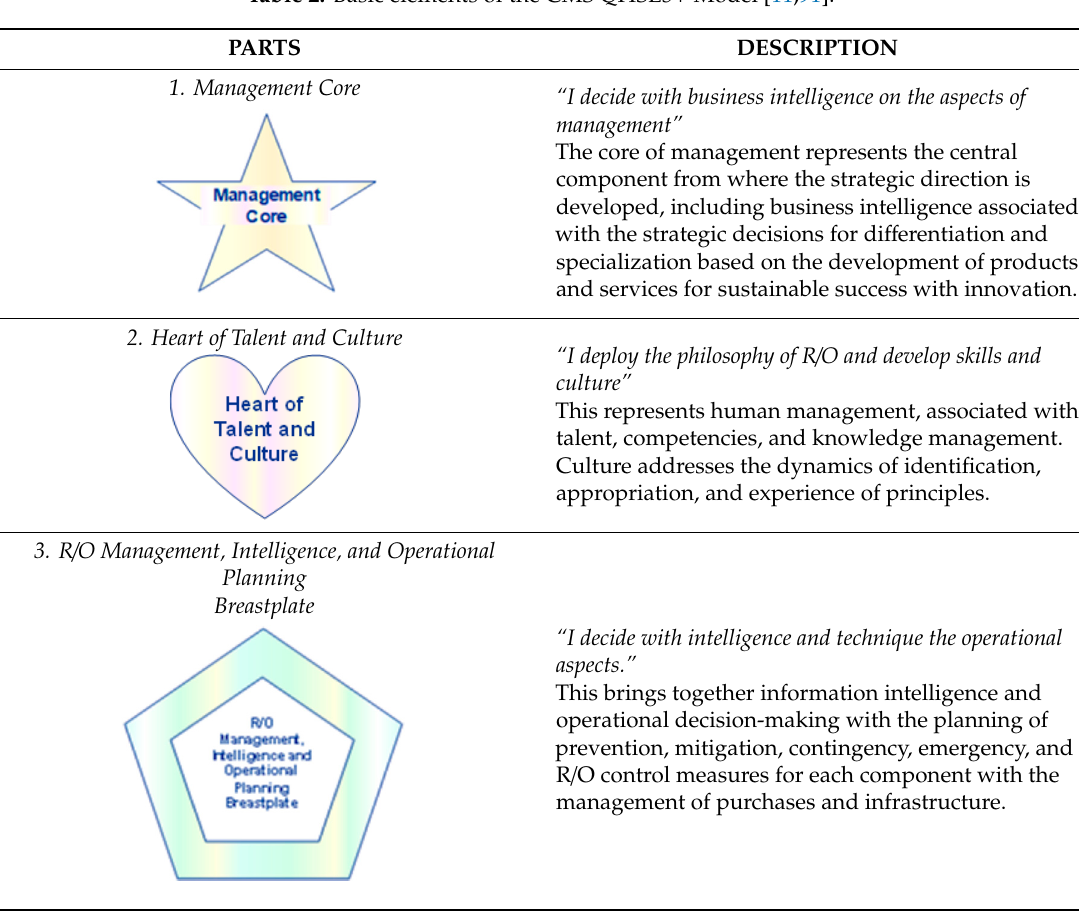
Table 2. Basic elements of the CMS QHSE3+ Model [11,91].